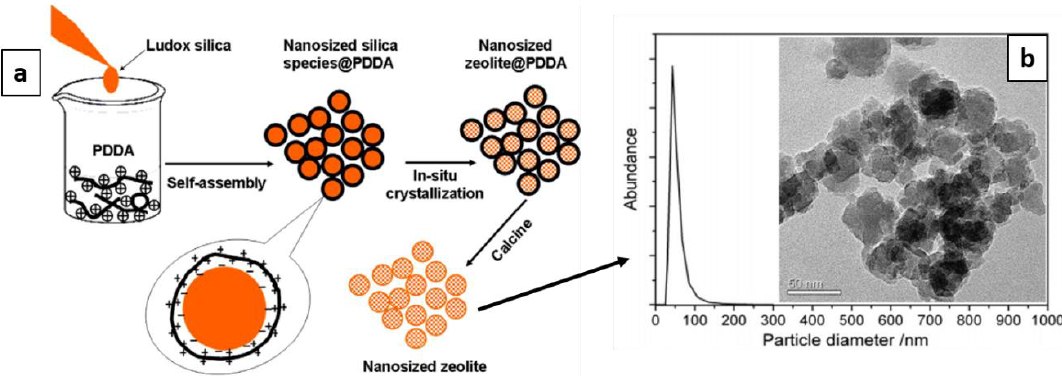
Figure 10. Scheme of the synthesis of nanosized MCM-22 using PDDA ( a ); particle size distribution and TEM of the obtained crystals ( b ). Adapted from Reference [62]. Copyright (2014), with permission from Elsevier.